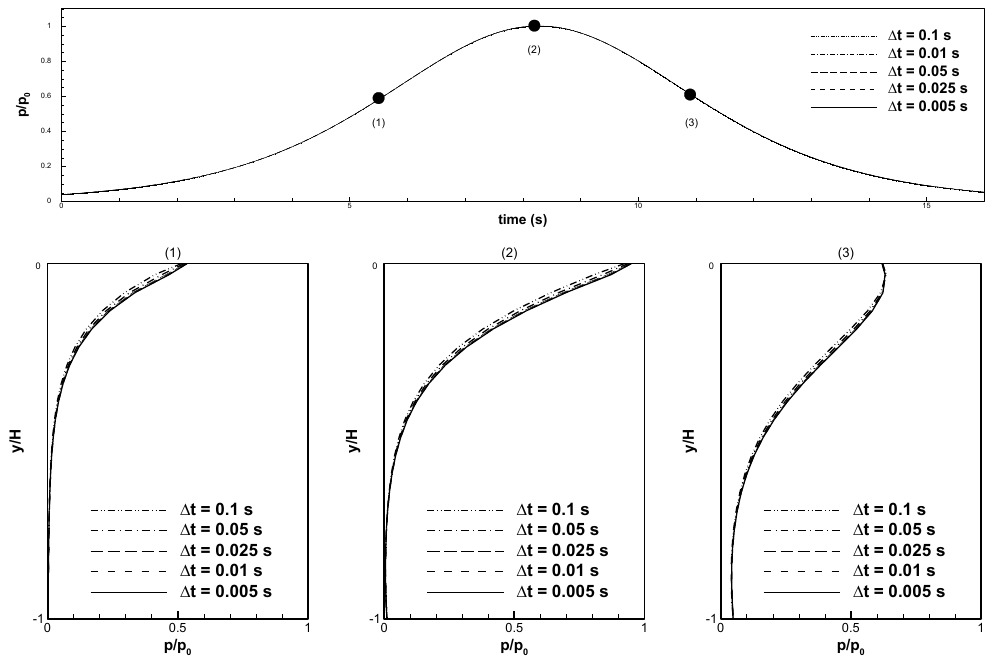
Figure 8. Distribution of excess pore-water pressure computed using different time